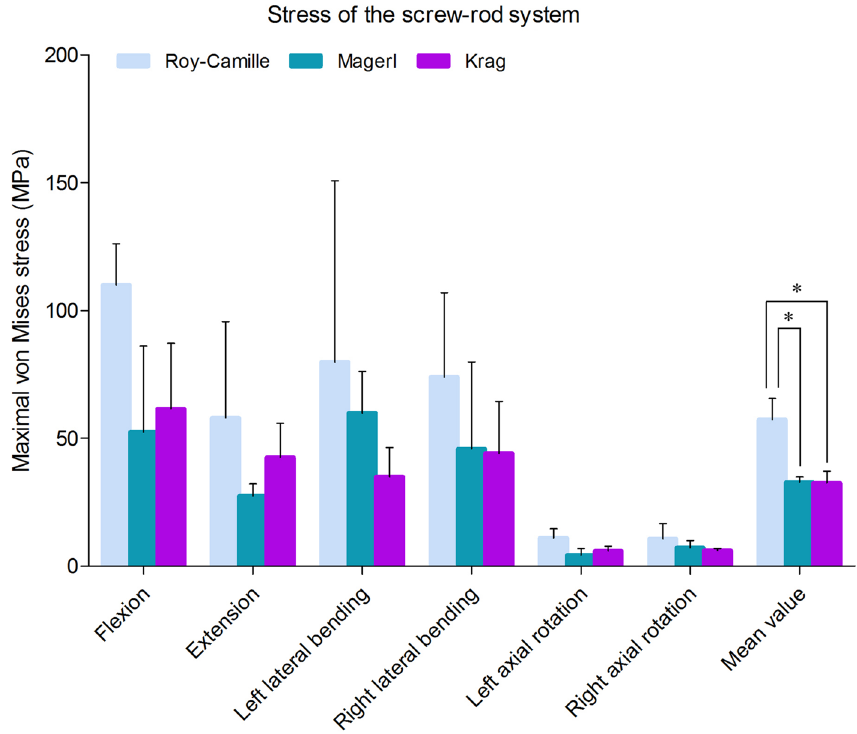
Figure 14. The stress value of screw-rod systems in three postoperative calf spine models under different conditions. (*: P <